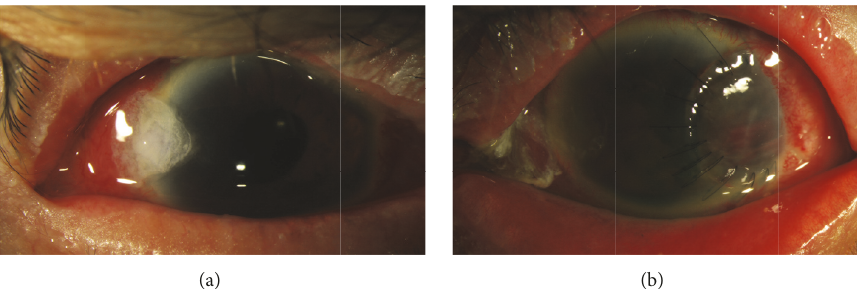
Figure 2: Slit-lamp photographs of the right eye (a) demonstrate a corneal glue and left eye (b) with corneal scleral patch graft.